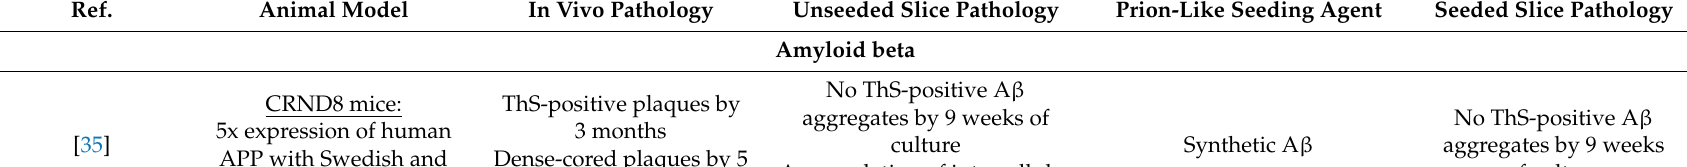
Table 3. Summary of in vivo and ex vivo experiments for prion-like protein aggregates, indicating type of mouse model used for culture and whether application of a prion-like seeding agent facilitated aggregation or pathology.